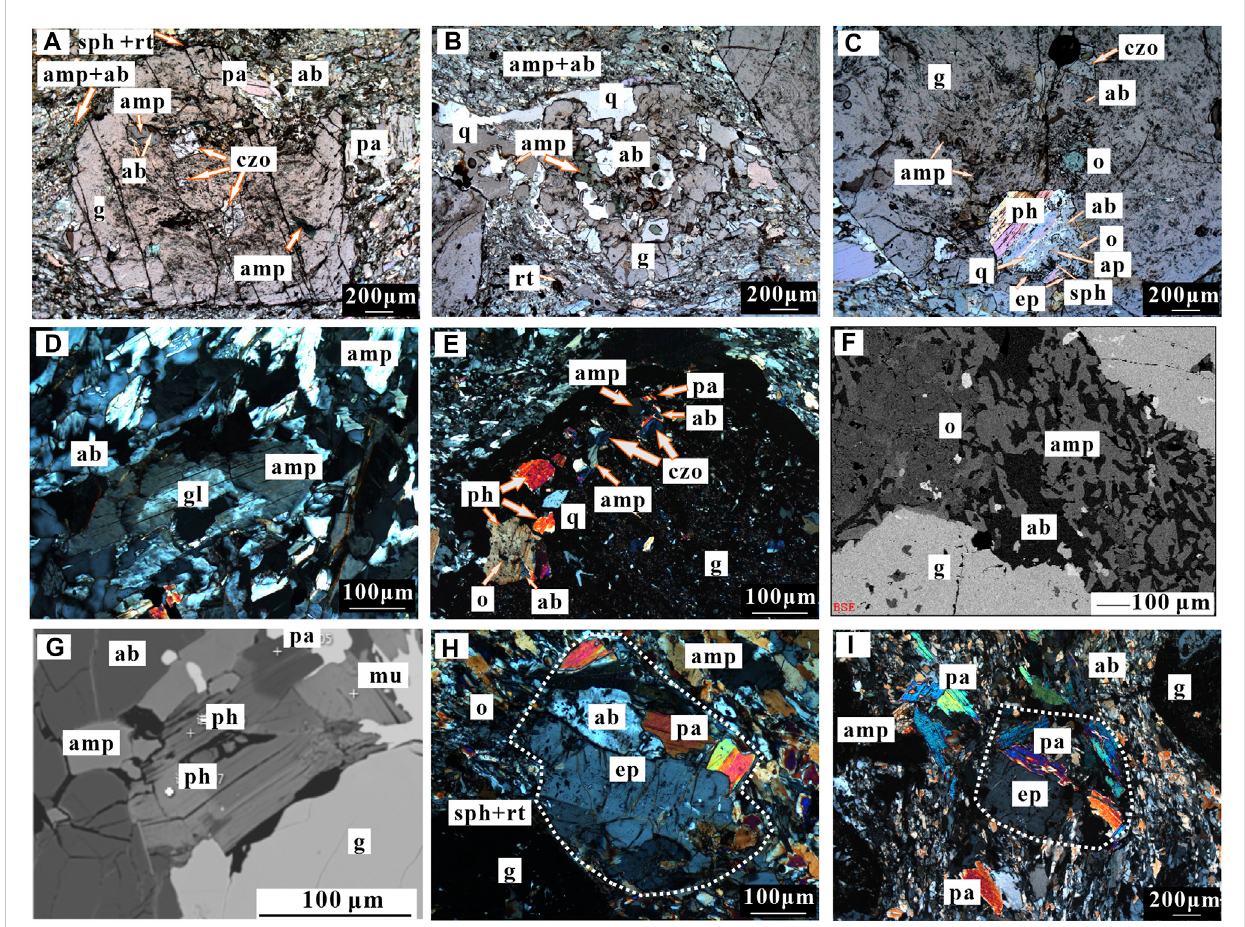
FIGURE 2 Photomicrographs showing texture features of eclogite at Gaoqiao, westernDabie under plan-polarized light (A – C) , cross polarized light (D – I) and in BSE images (F,G) . (A) Porphyroblastic garnet showing pink, inclusion-rich core and light-colored, rare inclusion rim. In garnet core, inclusions are mainly clinozoisite, paragonite, amphibole, quartz and ilmenite/sphene. Whereas in garnet rim, inclusions are mainly omphacite, quartz and amphibole. At places, amphibole + albite and sphene replaces garnet along rim. (B) Relic garnet eroded by quartz, albite and amphibole. (C) Polyphase mineral inclusions of phengite, epidote, quartz, albite, amphibole, and omphacite in garnet, interpreted to be pseudomorphs after lawsonite. (D) Amphibole porphyroblast in the matrix with glaucophane relics in the core. (E) Inclusions of phengite, paragonite, albite, clinozoisite and quartz in garnet rim. (F) Omphacite in the matrix replaced by symplectite of amphibole + albite. (G) High-Si phengite (darker, at core) in the matrix replaced by low-Si phengite (lighter, at rim) and paragonite (H,I) . In the matrix, aggregates of coarse-grained epidote, paragonite and albite showing box shape, interpreted to be pseudomorphs after